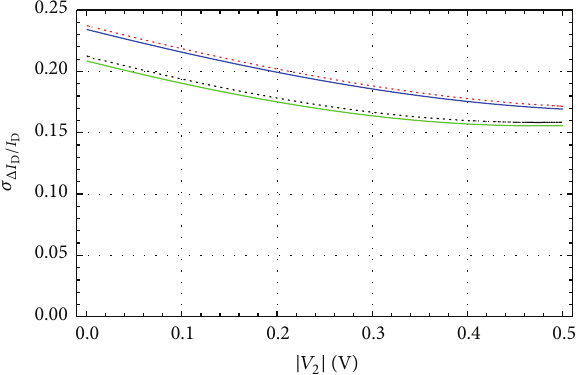
Figure 4: N-type and P-type subthreshold FGMOSFET based comparative plots against |𝑉 2 | where |𝑉 1 | = 0